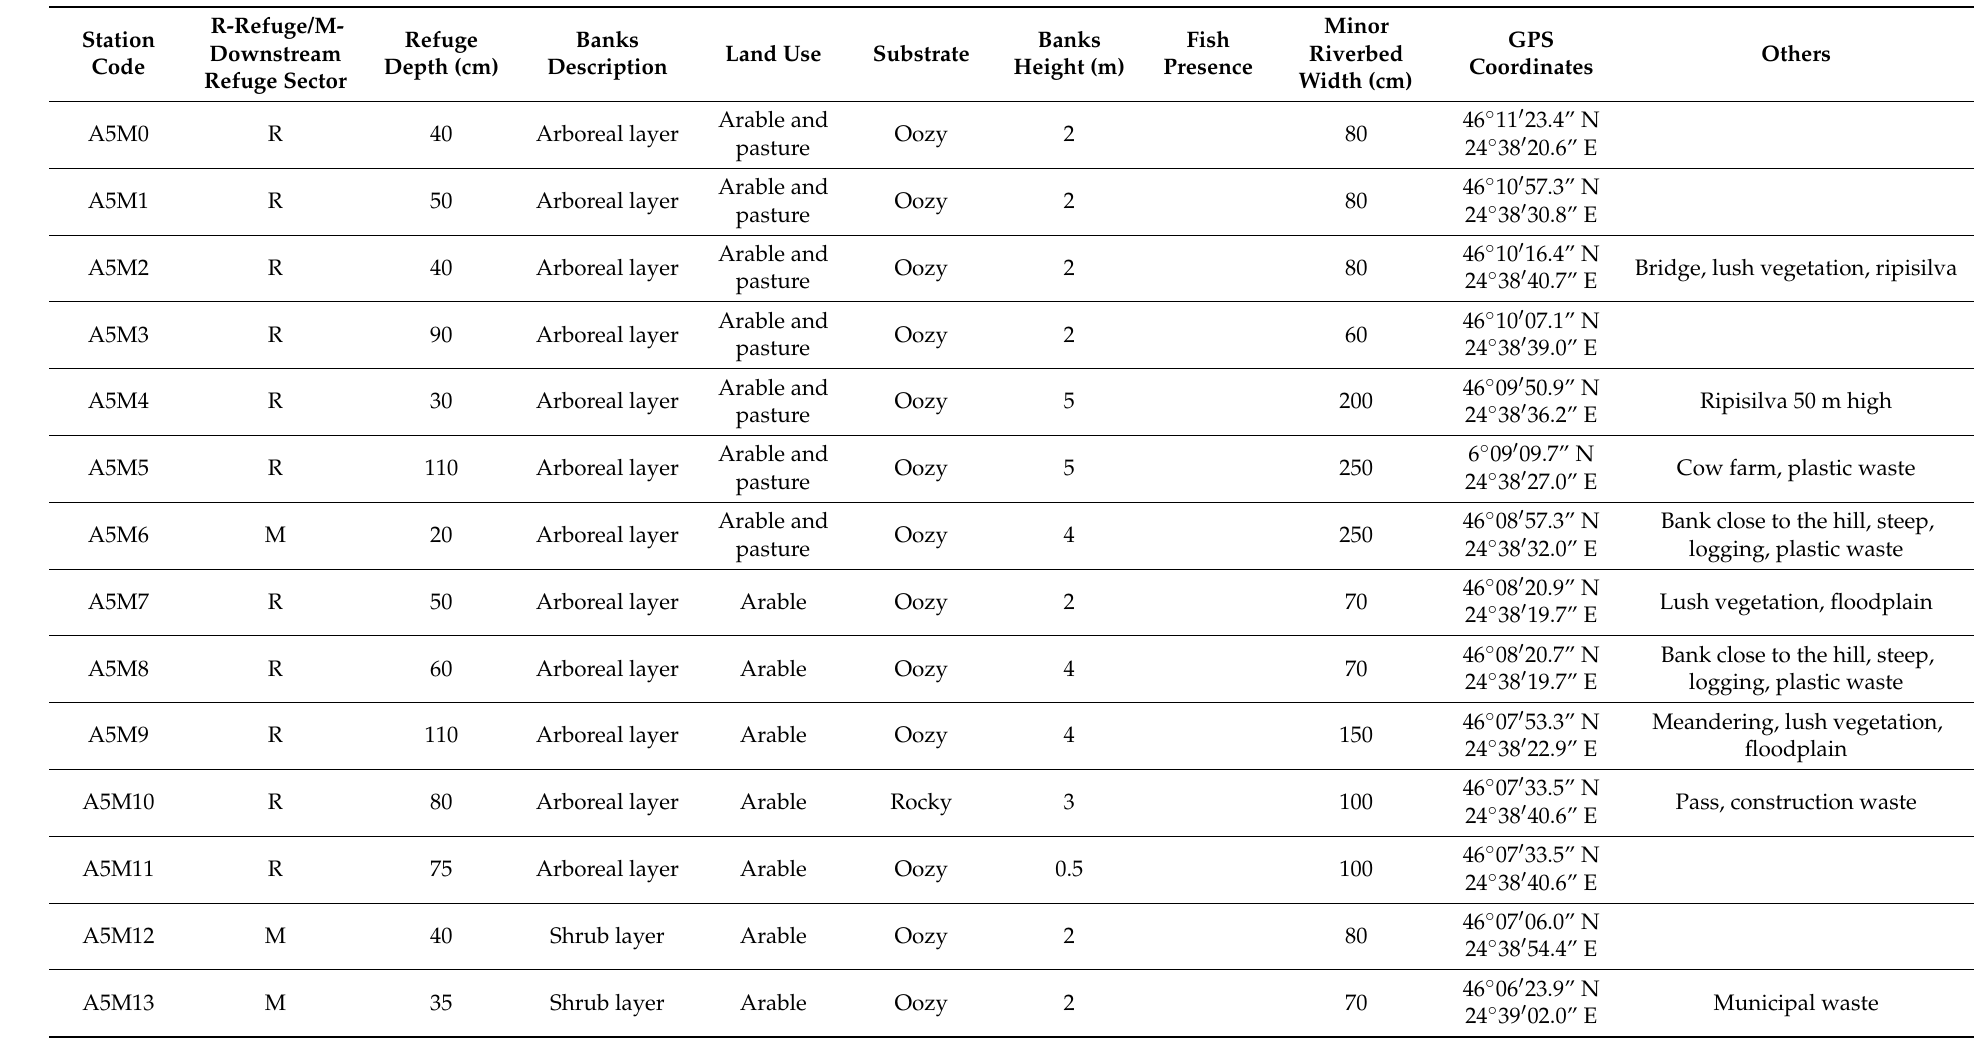
Table A5. M ă l â ncrav River Habitat